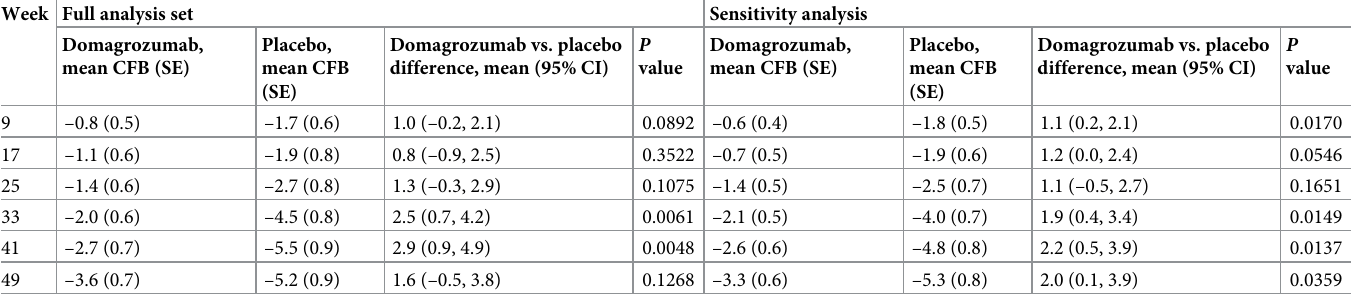
Table 2. Mean change from baseline (CFB) in the NSAA total score (from Week 9 to Week 49). Full analysis and sensitivity analysis, where temporary zero values were changed to “not obtainable” a . Week Full analysis